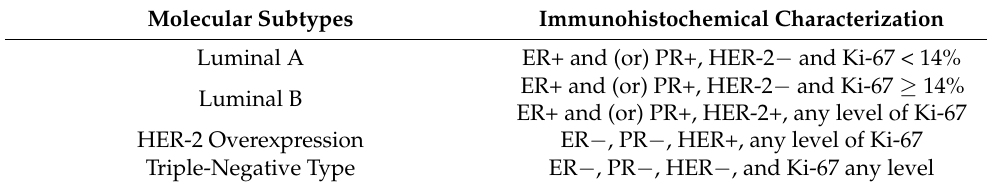
Table 1. Four molecular subtypes of breast cancer. Molecular